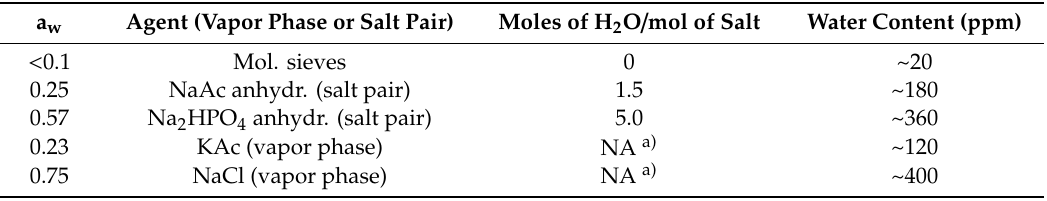
Table 1. Equilibration to different a w via vapor phase over a saturated solution of salt [47,51] and via the salt pair method [50]. All reaction components, except the acyl donor, were mixed and equilibrated overnight at 30 °C. Finally, dried and freshly distilled vinyl acetate was added in order to start the reaction. The water content was determined by Karl Fischer Titration after 48 h.